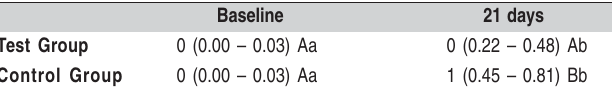
Table 1 – Plaque Index values (median (95% confidence interval)), before and after the use of control and test solutions.